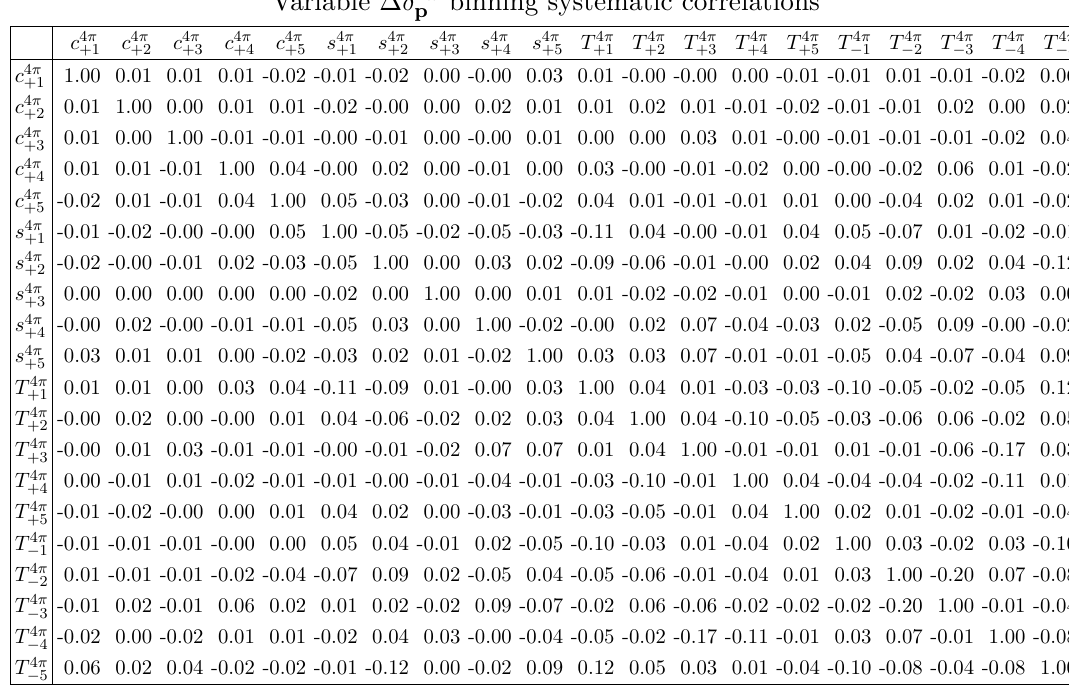
Table 10 . The statistical and systematic correlations between the 4 (cid:25) (cid:6) hadronic parameters using the Variable (cid:1) (cid:14) 4 (cid:25) binning scheme with N = 5. p